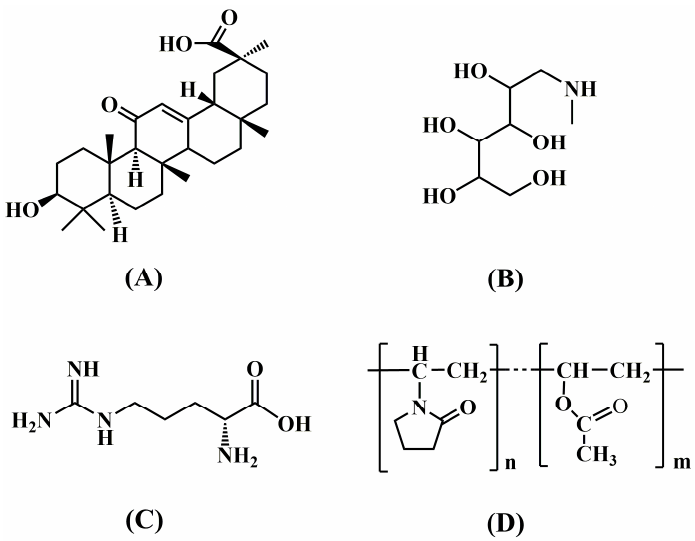
Figure 1. Chemical structure of glycyrrhetinic acid ( A ), meglumine ( B ), L-arginine ( C ), and Kollidon ® VA64 ( D ).